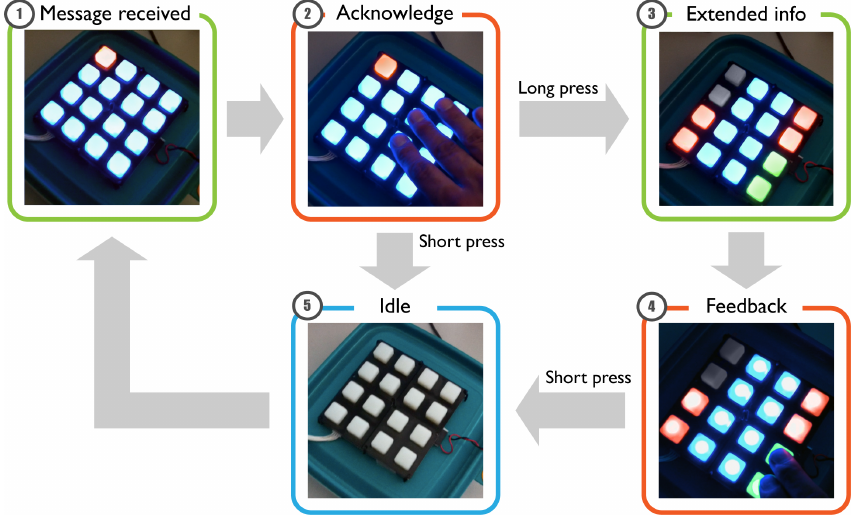
Figure 4. Distant Human to Human Communication on an augmented Tupperware TM